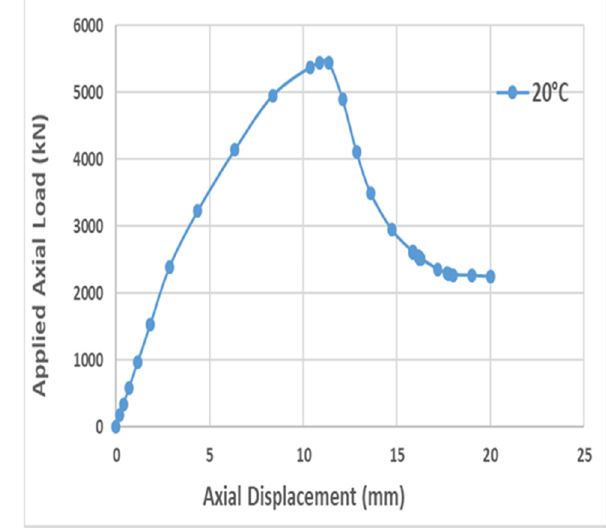
Figure 11: Load - vertical displacement without fi re ( reference column ) .